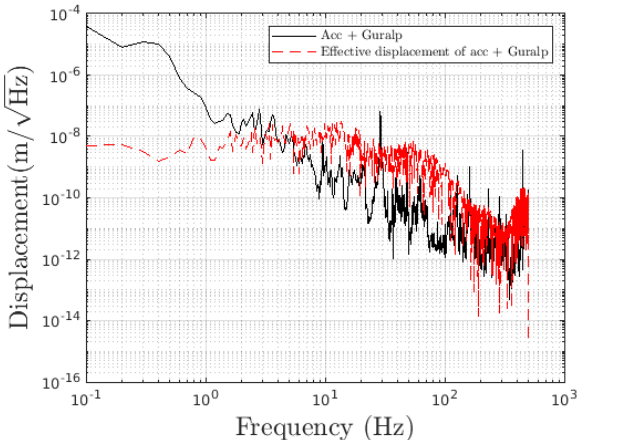
Figure 11. The black solid curve is the displacement of the cryobaffle, obtained from merging the data from an accelerometer and a velocimeter and then multiplying by the mechanical TF. The dashed red curve is the effective displacement, result of applying the fringe wrapping over the blue